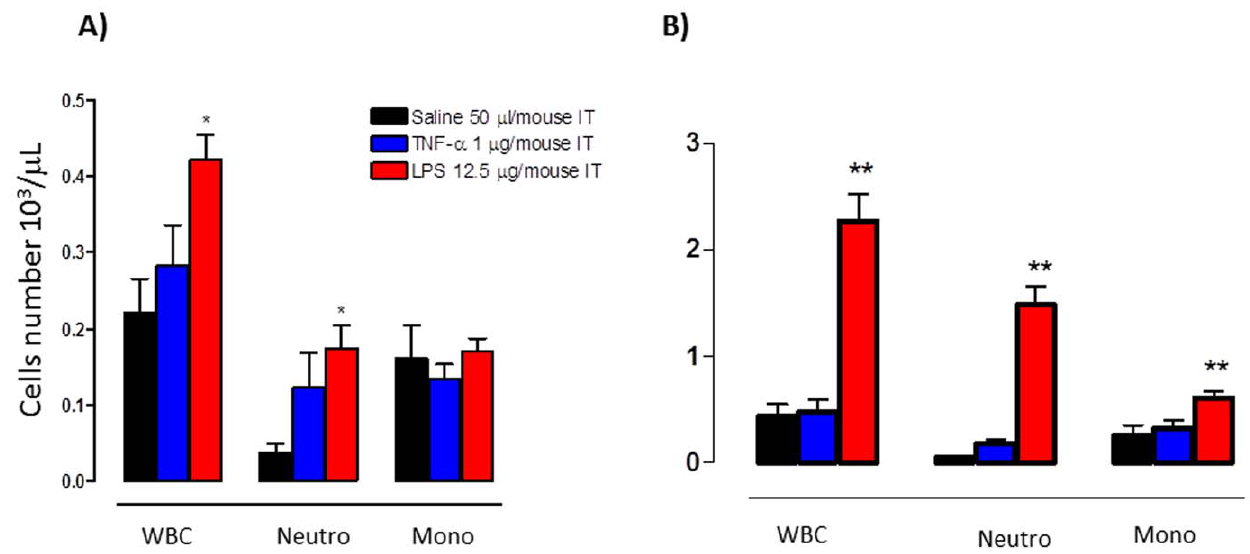
Figure 4. White blood cells and neutrophils infiltration. Cellular infiltration into the lung of mice intratracheally instilled with LPS, TNF- a or vehicle. The amount of White blood cells (WBC), Neutrophils (Neut) and Monocytes (Mono) found in BALF was expressed as number of cells per m l at 3 (A) and 24 hours (B) post treatment. The experiment was repeated three times and each point represents the mean 6 standard deviation of 9 animals. Data were expressed as folds of induction over vehicle-treated mice (Saline) and statistical differences were tested by One Way ANOVA followed by Dunnet’s post hoc test for group comparisons. Results are reported as mean 6 SD and significance attributed when P , 0.05 (*) or P ,